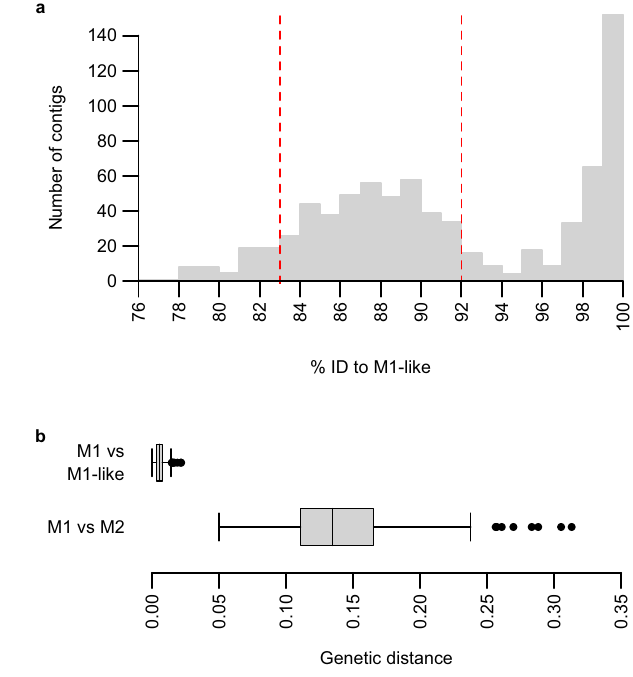
Fig. 2 P. malariae -related contigs from chimpanzee sample PGABG03. a Identity to M1-like genome assembly PmlGA01 of de novo contigs assembled from PGABG03 sequencing reads mapped to P. malariae . To improve readability, one contig with a nucleotide identity of 70% has been omitted from the plot. Contigs between 83% and 92% nucleotide identity to PmlGA01 (dashed red lines) were assumed to originate from M2 and used for further assembly; contigs between 92% and 97% identity or below 83% identity were evaluated manually and included as M2 contigs if appropriate. b Boxplot of nucleotide divergences between M1 and M1-like, and between M1 and M2; n = 285 genes, totalling 350 kb of aligned sequence. A vertical centre line indicates the median; the box indicates the interquartile range; whiskers indicate 1.5x the interquartile range; black circles represent outliers.